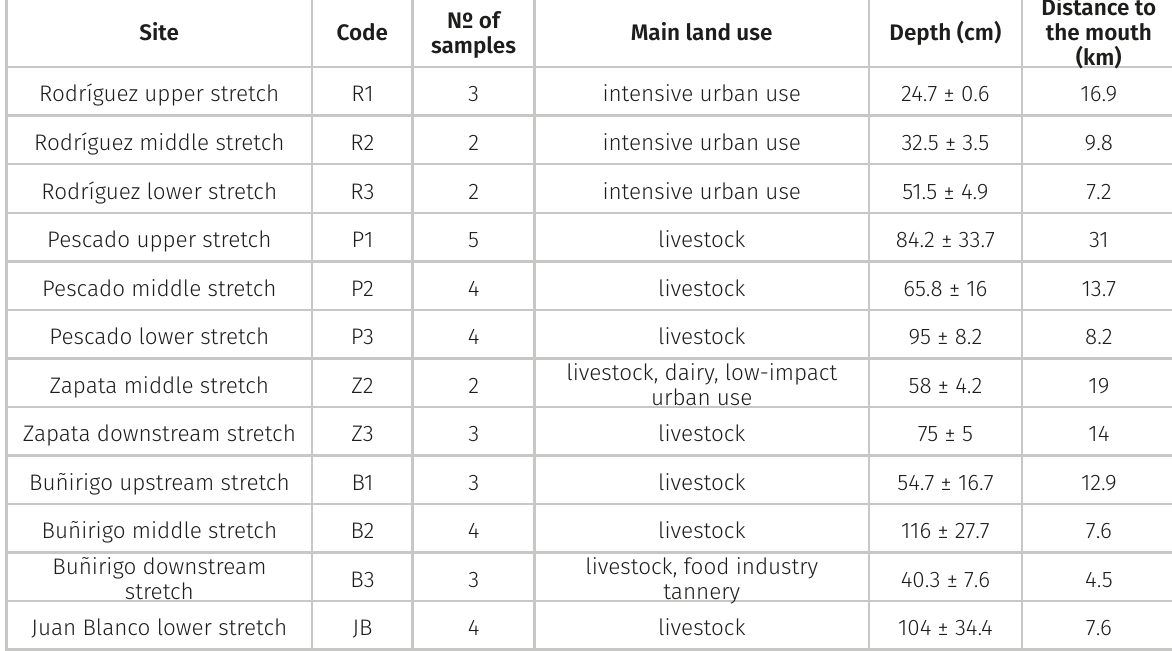
Table I. Features of the study sites on pampean streams, Buenos Aires province, Argentina. Distance to the mouth (km) measured in length of the downstream river